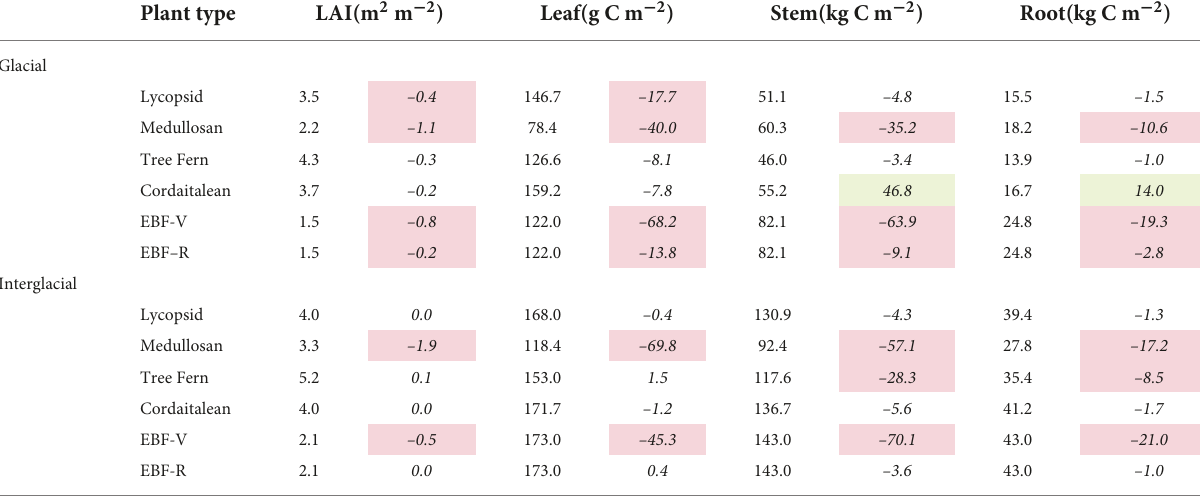
or sapwood allometric deficit), or reduce stomatal conductance (cordaitaleans: Table 2 , Figure 6 , green line, and Figure 8 , m sw ). Vulnerable plant types, on the other hand, had stomatal conductance reduced by as much as 82% on average by sapwood dysfunction (Glacial medullosan, Table 2 , Figure 6 , orange line, and Figure 8 , m sw ). In Paleo -BGC+, air-seeding and embolism (PLC) are the initial cause of sapwood dysfunction. Prolonged embolism also increased simulated sapwood turnover, and altered the allometry of conductive sapwood to supply the canopy with water, which is captured as a proportional cap on stomatal conductance (g ∗ s , max , Table 2 , Figure 6 , dotted line, and Figure 8 ).